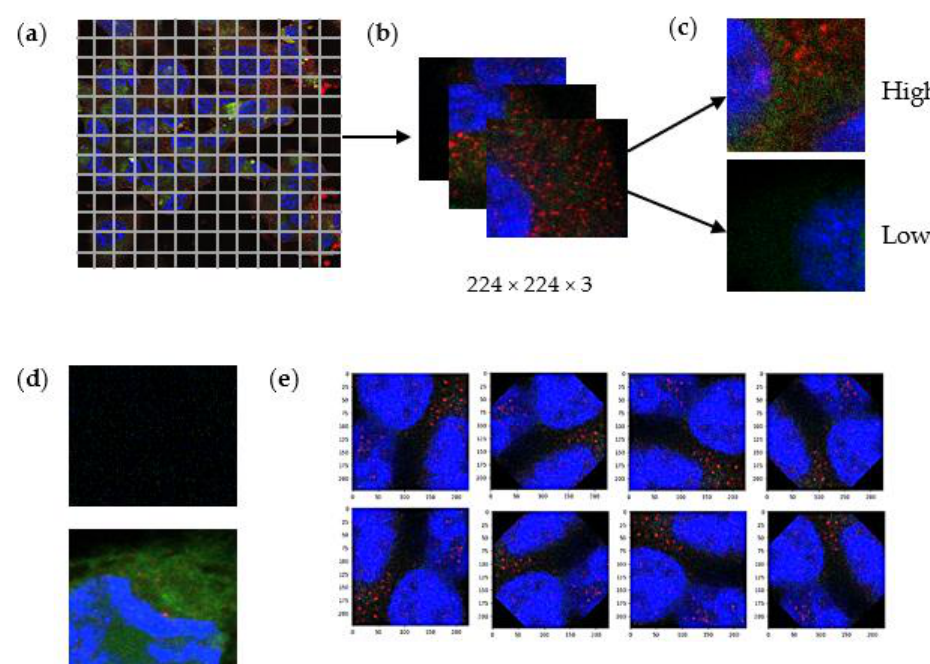
Figure 5. Illustration of data processing technique: ( a ) Patch sizes to 224 by 224 pixels ( b ) Resulting patch images ( c ) Image classification into high or low classes based on the green fluorescent signal ( d ) Excluded images ( e ) Data augmentation of individual patched image .